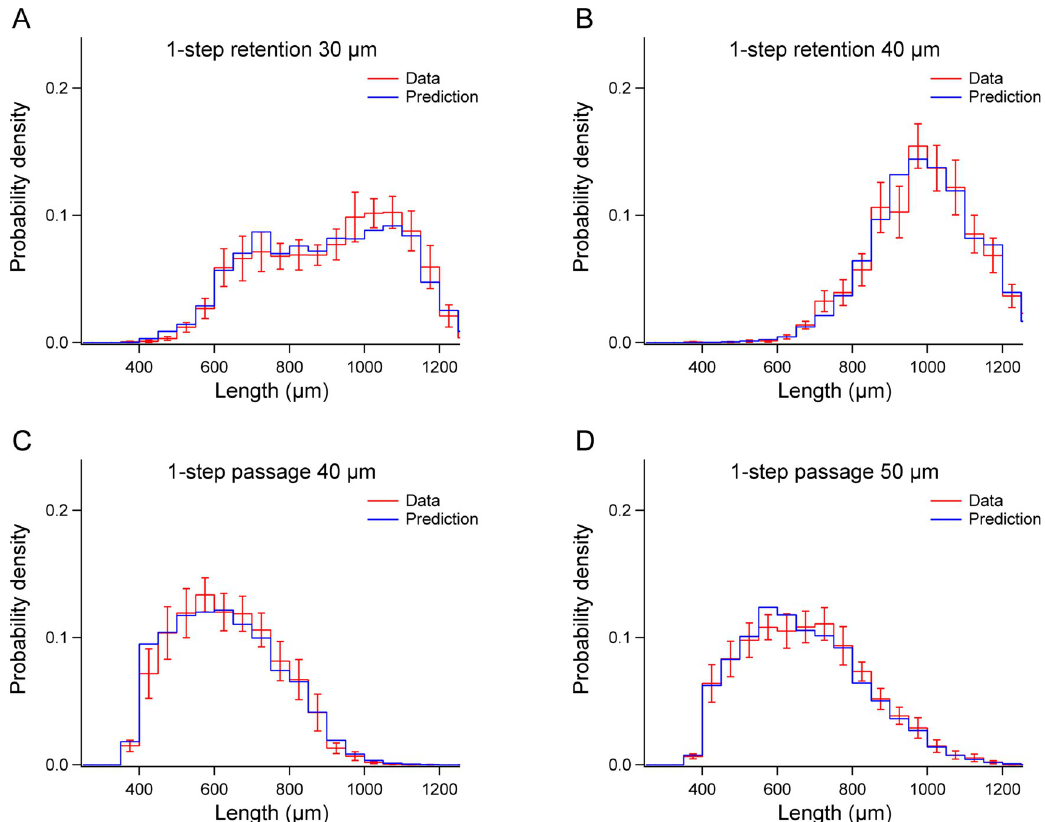
Fig 5. Validation of 1-step filter functions. A-D. In each panel, the unfiltered length distributions H panel of Fig 3 were multiplied by the filter functions in the corresponding panel of Fig 4, yielding the blue trace (Prediction). The r ed trace (Data) shows the actual filtered distribution H